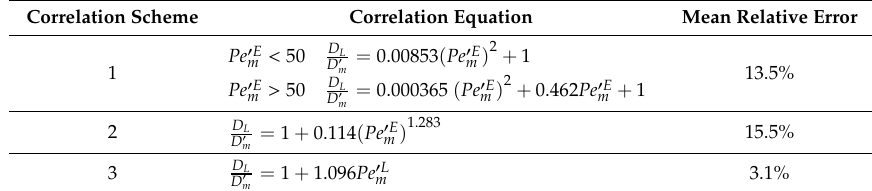
Table 5. Three correlation schemes for hydrodynamic dispersion of particles transport in RPS- packed bed.